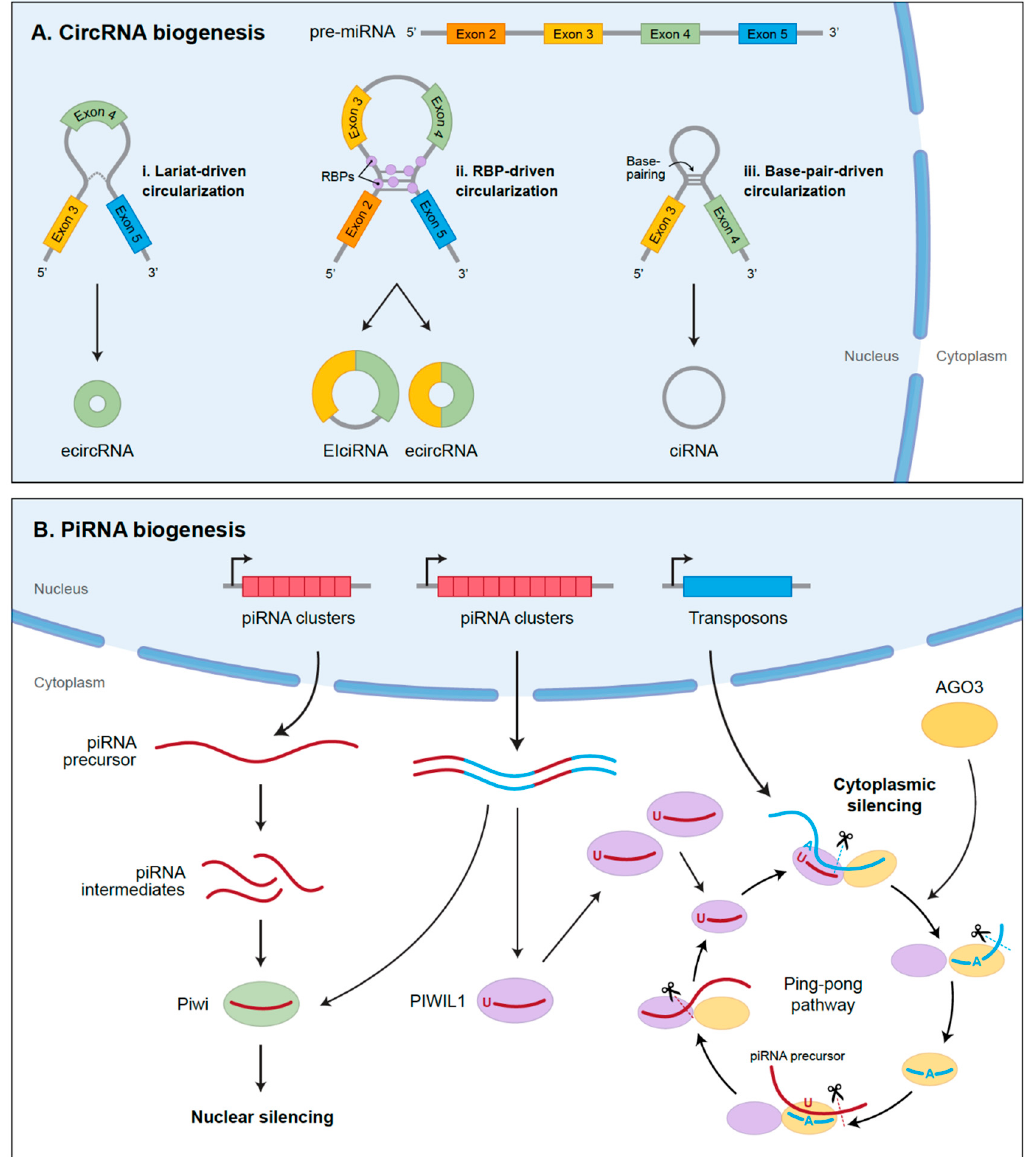
Figure 4. Biogenesis of circRNA and piRNA. ( A ) CircRNAs are generated from pre-mRNA through back-splicing, connecting 5’ splice site to an upstream 3’ slice site. The exon circRNAs (ecircRNAs) are synthesized by either RNA-binding protein (RBP)-driven circularization or lariat-driven circularization that involves exon skipping due to partial folding of the RNA during transcription of the pre-mRNA. Exon intron circRNAs (EIciRNAs) retain the introns during biogenesis, whereas ciRNAs are derived from lariat intron that is excised from pre-mRNA. ( B ) PiRNAs are transcribed from piRNA clusters and are processed from single-stranded precursor transcripts. They are then loaded onto Piwi or PIWIL1 (or its isoforms PIWIL2, PIWIL3, and PIWIL4). Alternatively, they are amplified through the Ping-Pong cycle, in which PIWI proteins associated with antisense piRNAs cleaves piRNA precursors in the sense strand, or vice versa. The Ping-Pong pathway silences the expression of the target transposon, while simultaneously amplifying the piRNA sequence.